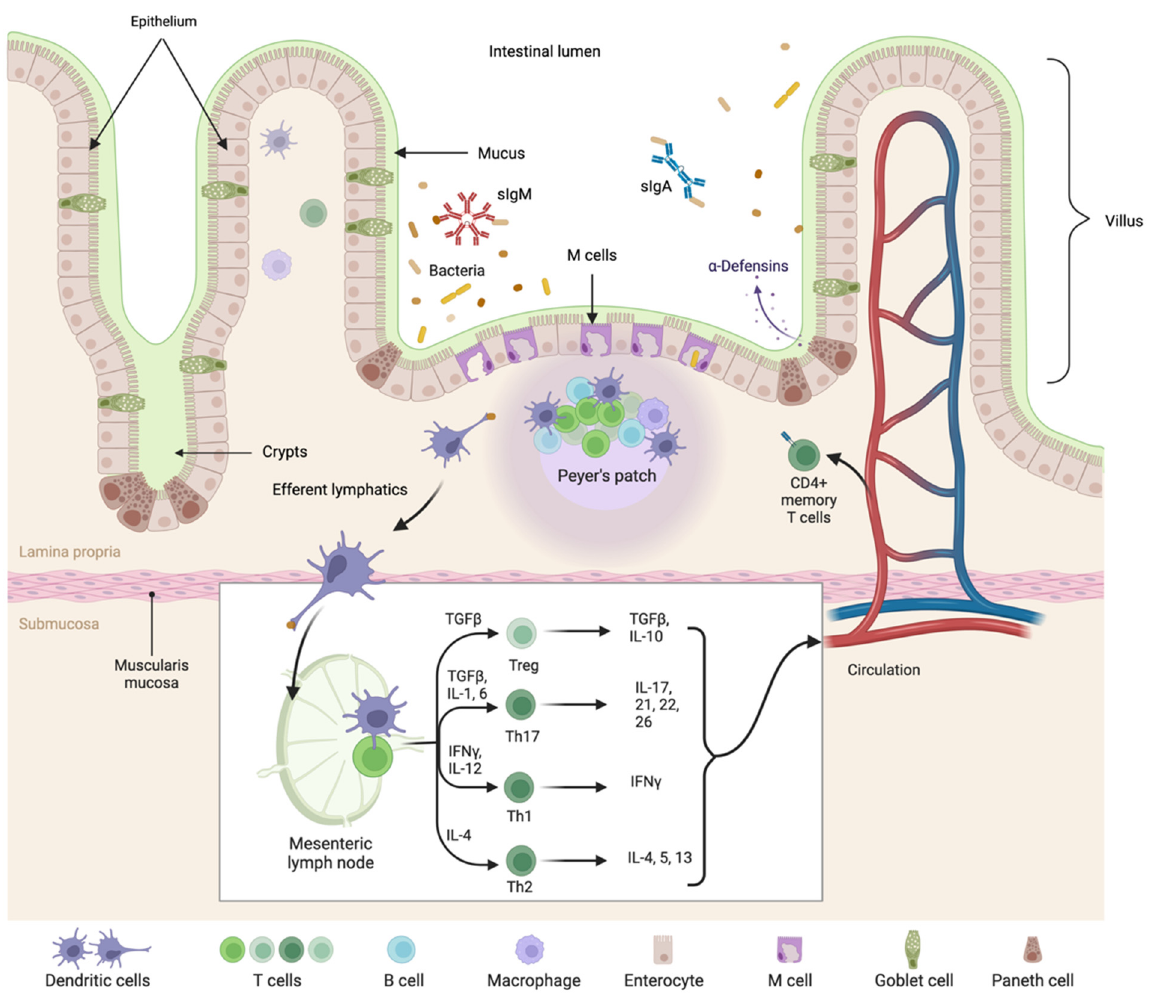
Figure 1. The architecture of the small intestinal GALT [20].